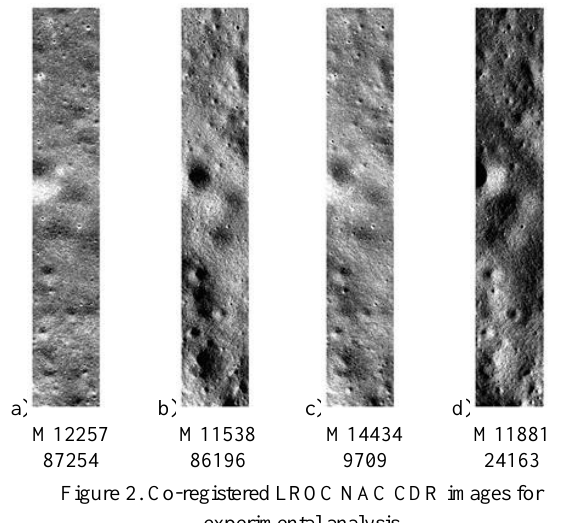
Figure 2. Co-registered LROC NAC CDR images for experimental analysis